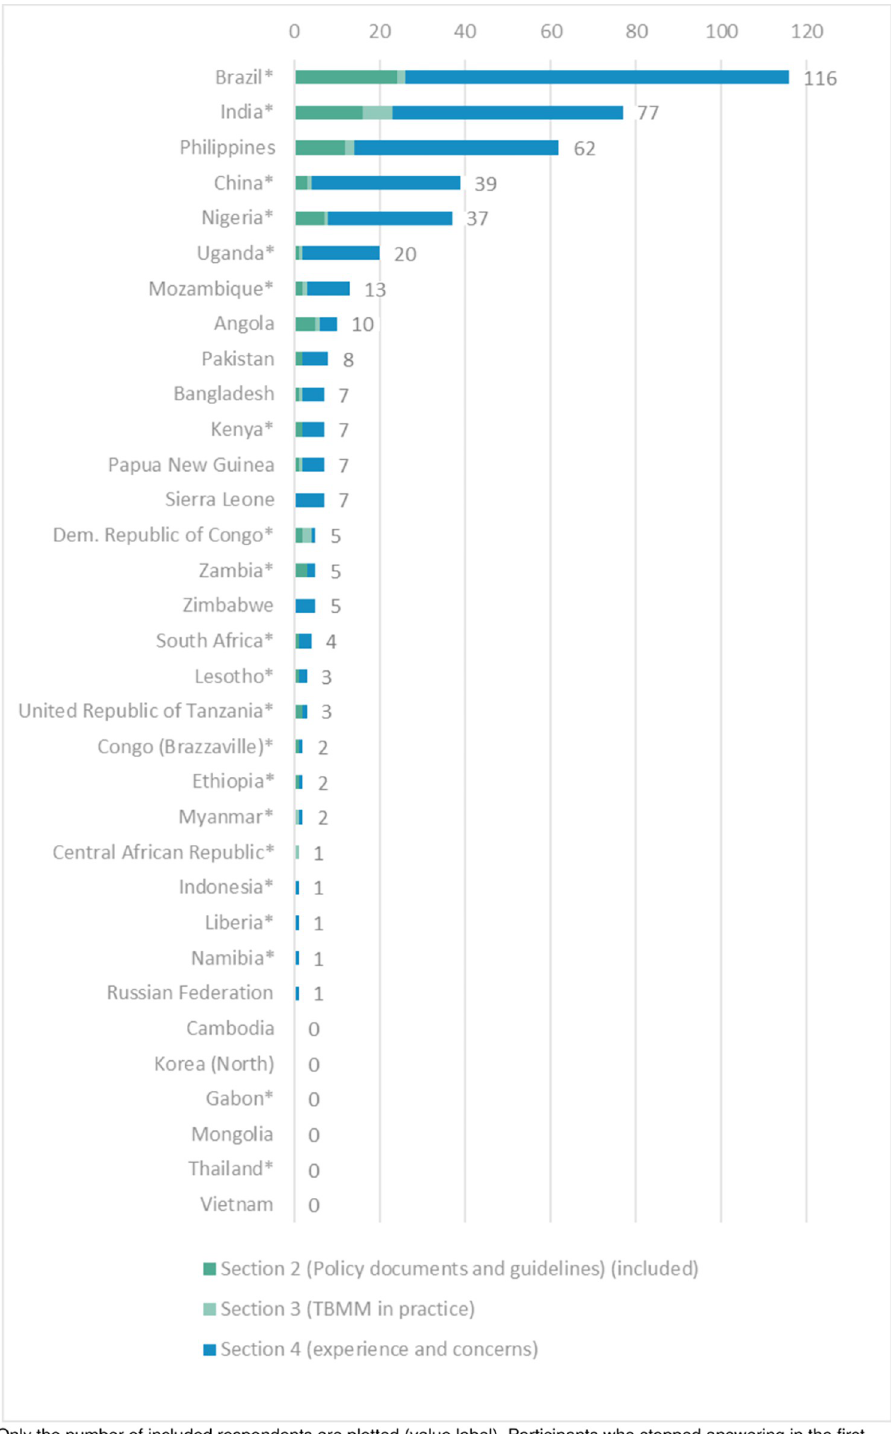
Fig 1. Number of respondents completing sections of the survey by country. Only the number of included respondents are plotted (value label). Participants who stopped answering in the first section of the survey (regarding participants characteristics) were excluded. Countries that are also in the TB/HIV high burden list are indicated with an asterisk [ � ].